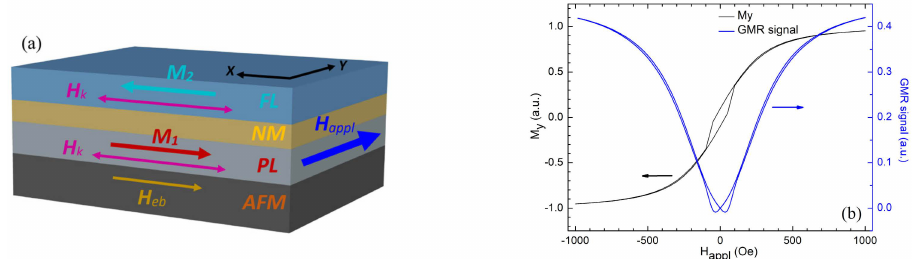
Figure 3. ( a ) Typical structure of a GMR sensor; (AFM—antiferromagnetic pinning layer; PL—pinned magnetic layer; NM—nonmagnetic spacer layer; FL—free magnetic layer ( b ) The simulated field dependence of the magnetization along the Oy axis (My) and the calculated GMR e ff ect when H appl is directed over the Oy